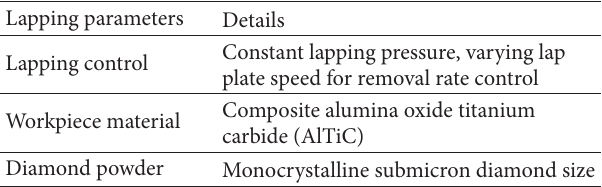
Table 1: Lapping parameters in the